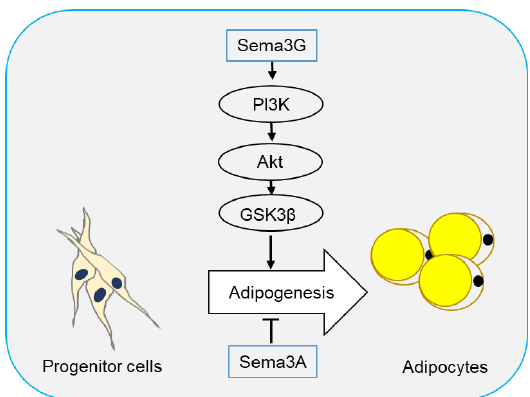
Figure 2. Semaphorins in adipogenesis. Adipocytes originate from progenitor cells through a process called adipogenesis. Sema3G has been reported to stimulate adipogenesis through the PI3K/Akt/GSK3β signaling pathway, while Sema3A plays an inhibitory role. Sema3G is a secreted semaphorin highly expressed in adipocytes and can be induced by PPARγ in endothelial cells [81]. Sema3G utilizes Nrp1, but not Nrp2, as a receptor to induce the repulsion of